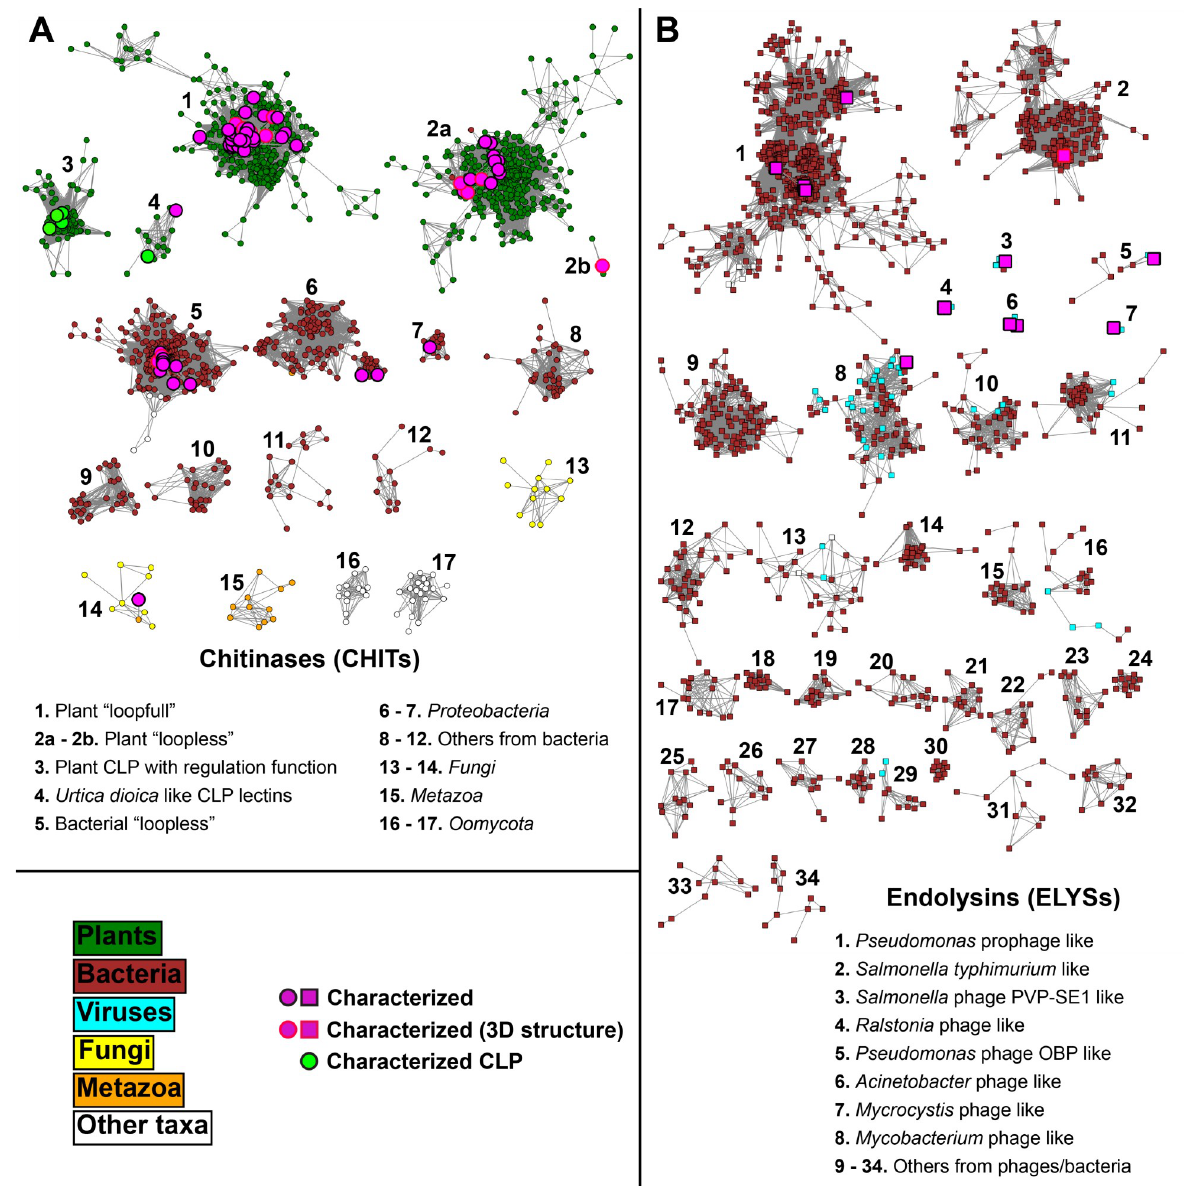
Fig 3. Protein sequence networks of representative domains of CHITs (A) and ELYSs (B) (1860 nodes for CHITs and 1521 nodes for ELYSs, respectively), connected by edges with a sequence identity threshold of 60%. The prefuse force-directed OpenCL layout with respect to the edge weights was used for network visualization. The domains were extracted by using profile HMMs of CHITs and ELYSs (generated in this study) to scan the sequences in the GH19ED database. Nodes are colored according to their annotated taxonomic source. Seed sequences are highlighted, with a different border if a structure is available in the PDB. Nodes representing characterized “chitinase-like” proteins (CLPs) are also highlighted and presented in S3 Table . chitinases (CHIT 1) and “loopless” or class IV chitinases (CHIT 2a-b). Clusters 2a and 2b were merged into one group, because both contain sequences characterized as class IV “loopless” chitinases from plants (CHIT 2a) or from Bryophyta (CHIT 2b). The term “plant” is used to indicate Embryophyta , with two exceptions from the green algae Klebsormidium nitens in CHIT 1. Two smaller groups (CHIT 3 and 4) contain plant proteins characterized as non-